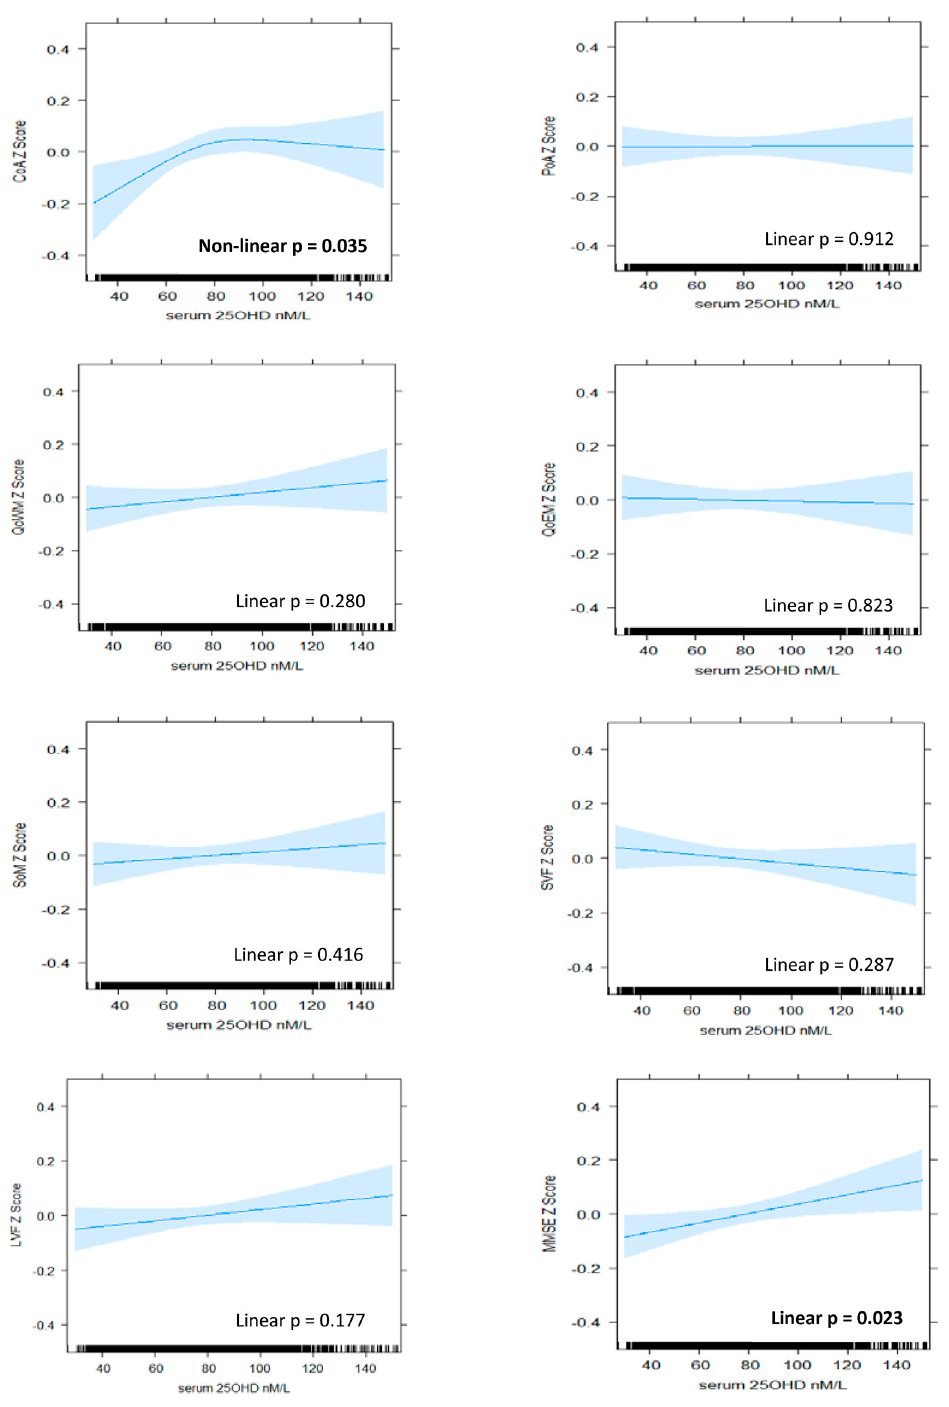
Figure 1. The association between serum 25OHD level (nM/L) and cognitive z -scores in BHAS women. Plots derived from ‘best fit’ of nonlinear (RCS) versus linear and fully adjusted models (Model 4). Model 4 includes de-seasonalised serum 25OHD level, age, estimated IQ, BMI, alcohol consumption, smoking status, physical activity, sitting hours per day, employment status, self-reported use of vitamin D supplements, self-reported health status, individual histories of hypertension, cardiovascular disease, diabetes, depression, and anxiety. CoA, continuity of attention; PoA, power of attention; QoWM, quality of working memory; QoEM, quality of episodic memory; SoM, speed of memory; SVF, semantic verbal fluency; LVF, letter verbal fluency; MMSE, Mini-Mental State